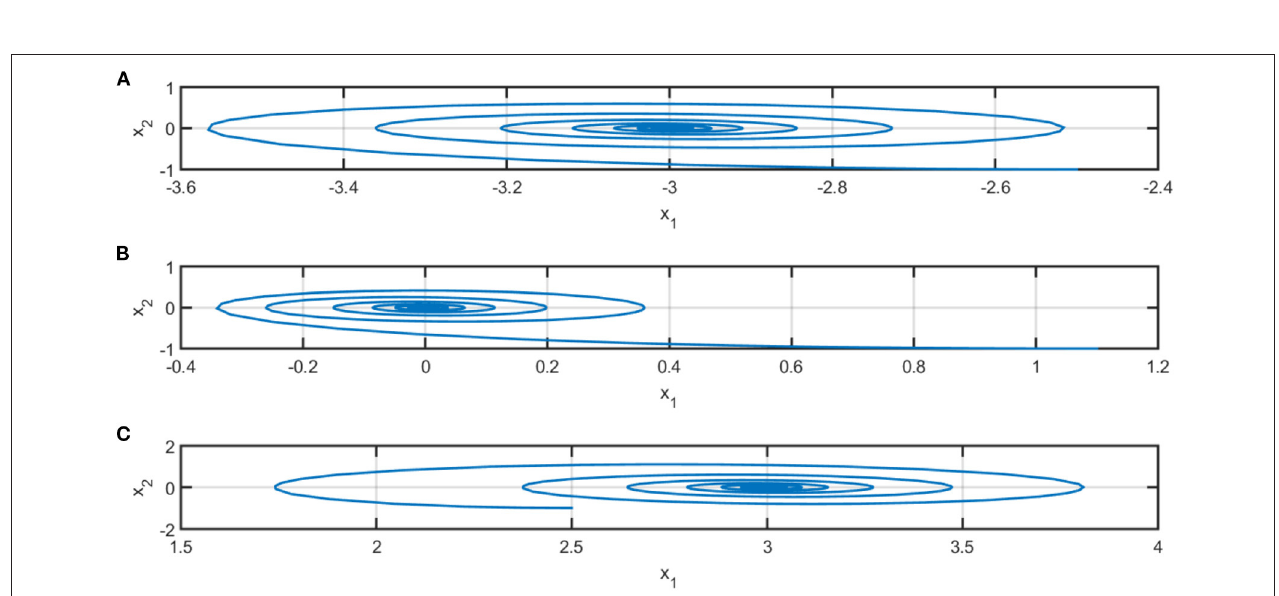
FIGURE 2 | Projections onto the x 1 x 2 plane of the three final possible attractors of the multi-stable system of equation (7). axplusbmultimethod. Plot (A) corresponds to the initial condition x (0) = ( − 2.5, − 1,0); Plot (B) to x (0) = (1.1, − 1,0); and Plot (C) to x (0) = (2.5, − 1,0).